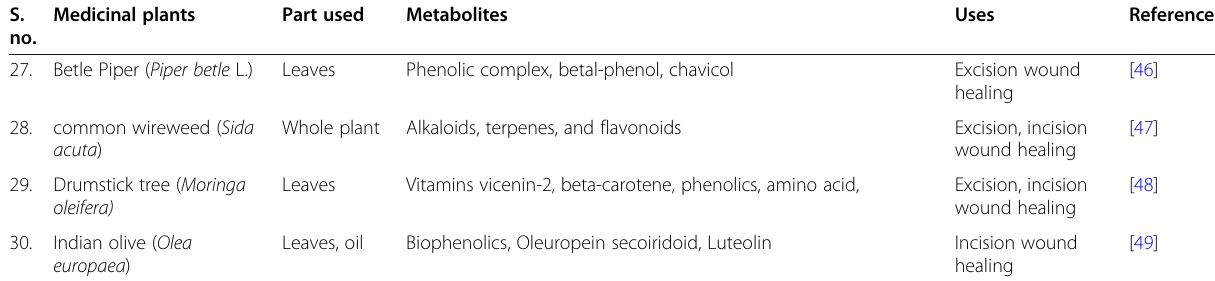
Table 1 Medicinal plants and their metabolites used for treating different types of wounds